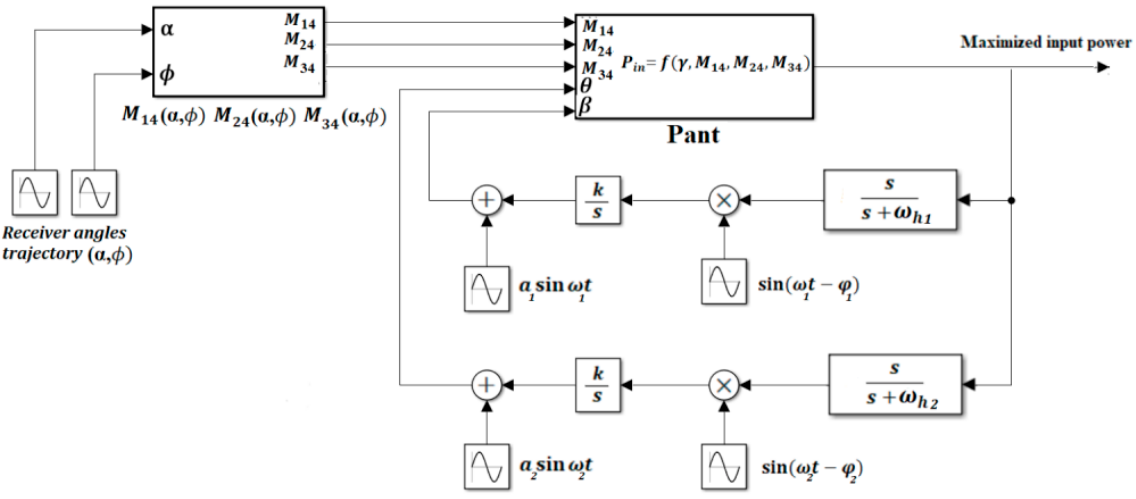
Figure 21. Extremum seeking scheme for 3D omnidirectional WPT power maximisation.